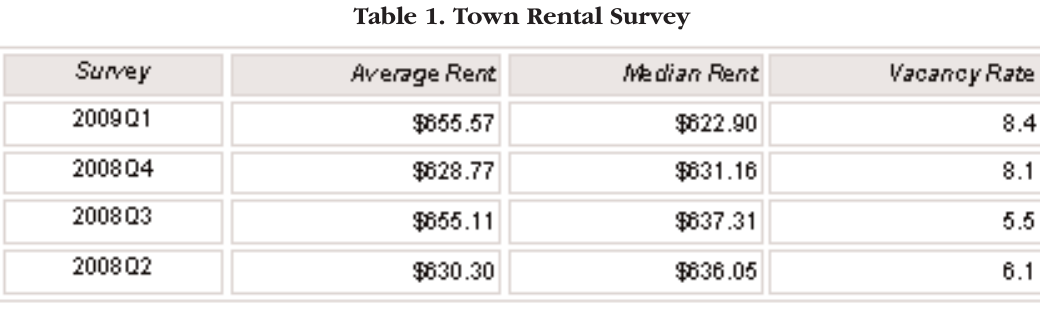
Table 1. Town Rental